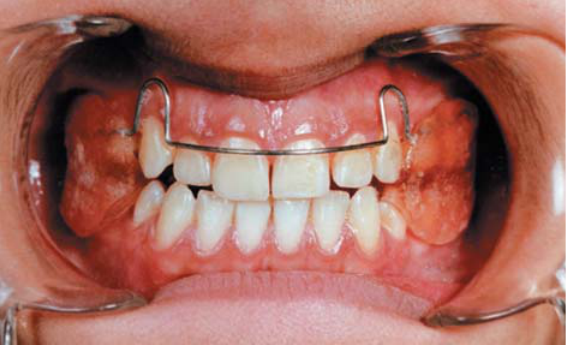
Figure 1- R-appliance in patient’s mouth